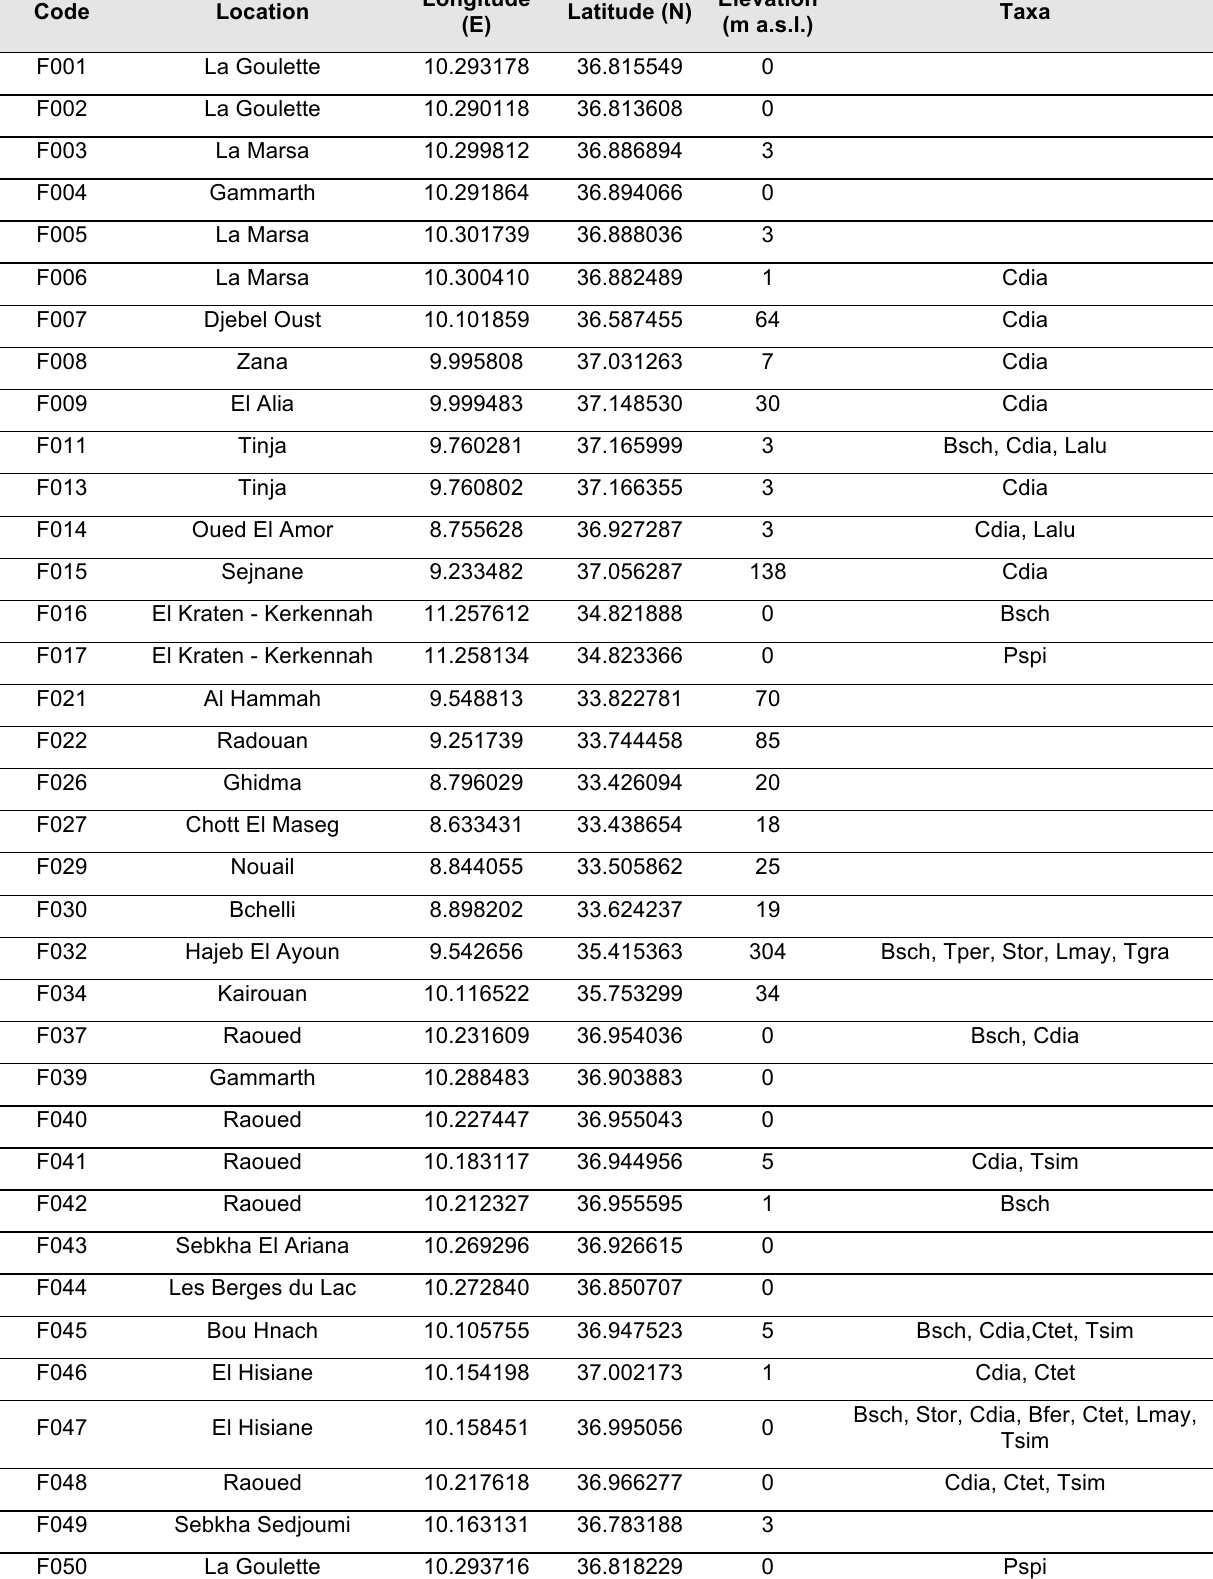
TABLE 1. List and characteristics of the sampled sites. See Table 2 for the